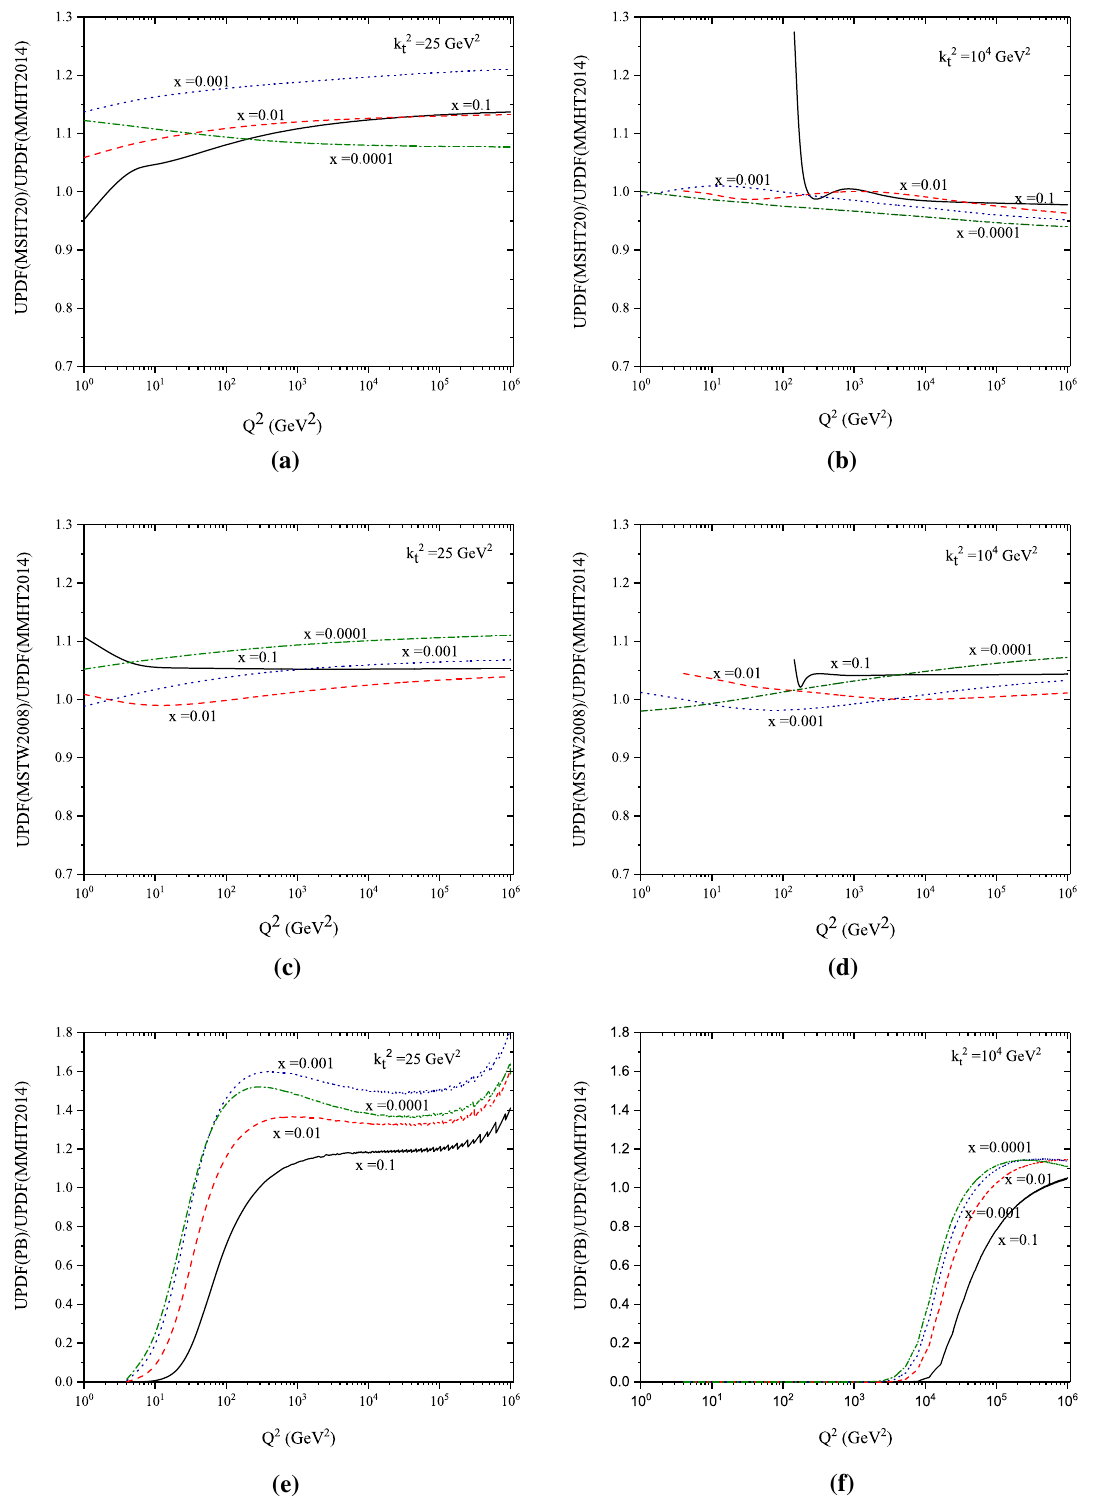
Fig. 3 The different up quark UPDFs ratios of various groups PDFs sets with respect to MMHT2014 one, at the two k 2 t and the four x values: the panels a –